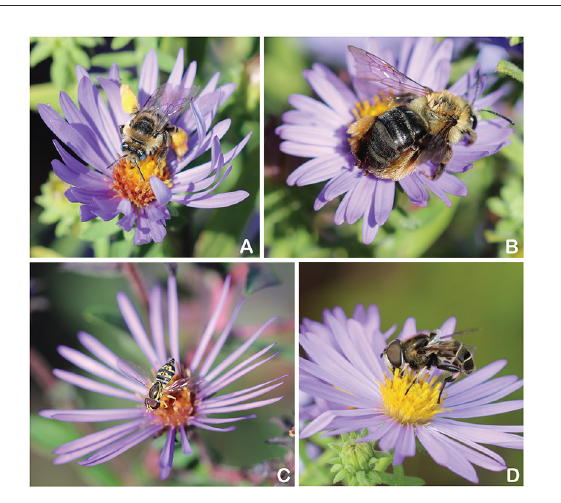
in this study were Salvia greggii “Radio Red”, Salvia guaranitica “Black and Blue”, Salvia microphylla x greggii “Heat